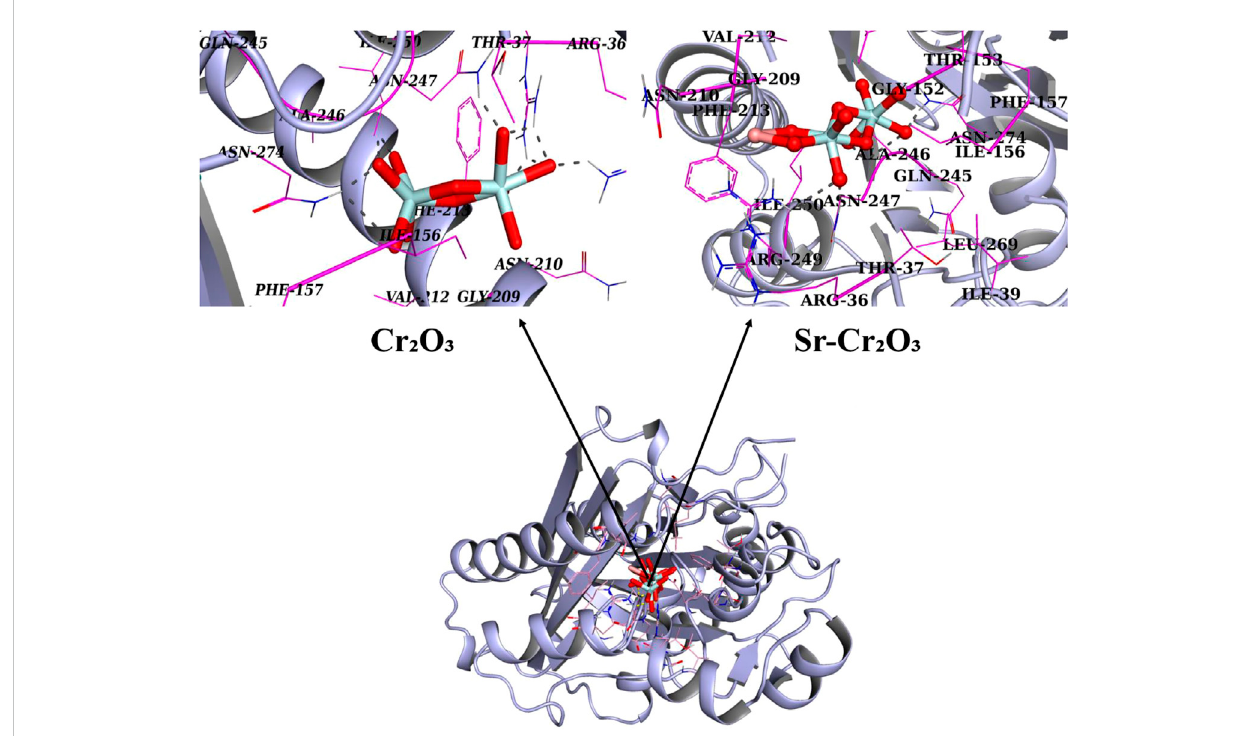
FIGURE 11 3DgraphicalrepresentationofbindinginteractionpatternsofCr 2 O 3 andSr-dopedCr 2 O 3 nanocompositesinsideactivepocketsofFabHfrom E.Coli (FabH E. Coli ).